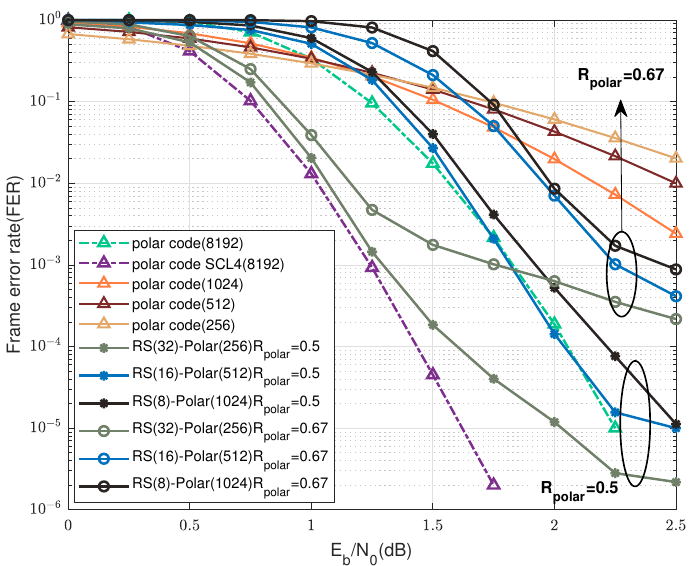
Figure 7. Performance comparison of the UEP-RS-polar product codes, the SC decoding and SCL decoding of long polar codewords over AWGN channels when R tx ≈ 1/3 and R polar =